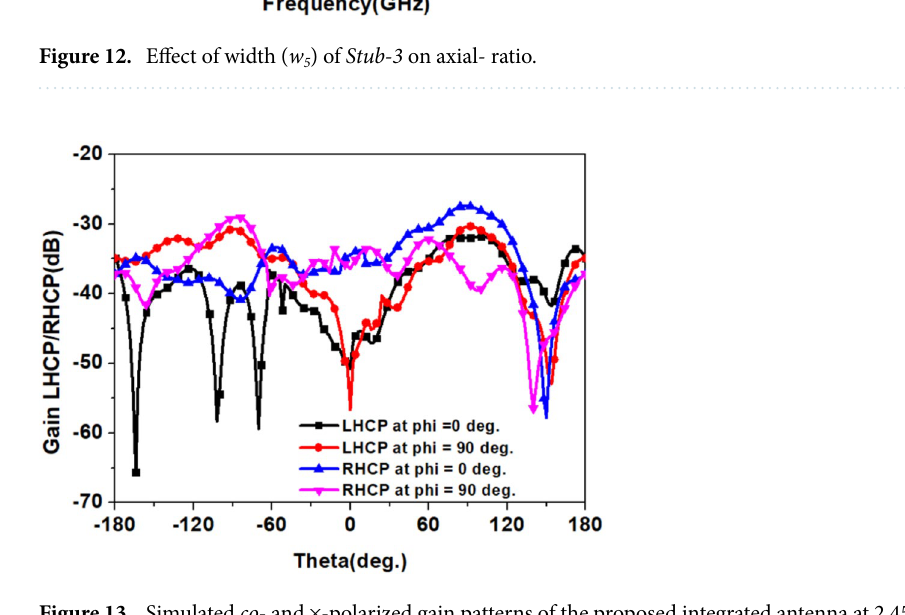
Figure 13. Simulated co- and × -polarized gain patterns of the proposed integrated antenna at 2.45 GHz.